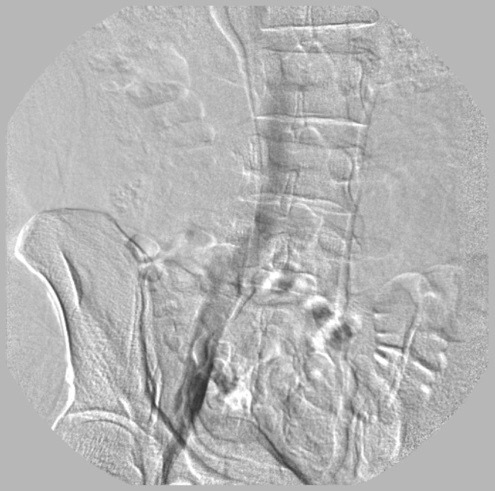
Ascending phlebography showing iliac vein and inferior vena cava with no abnormalities.